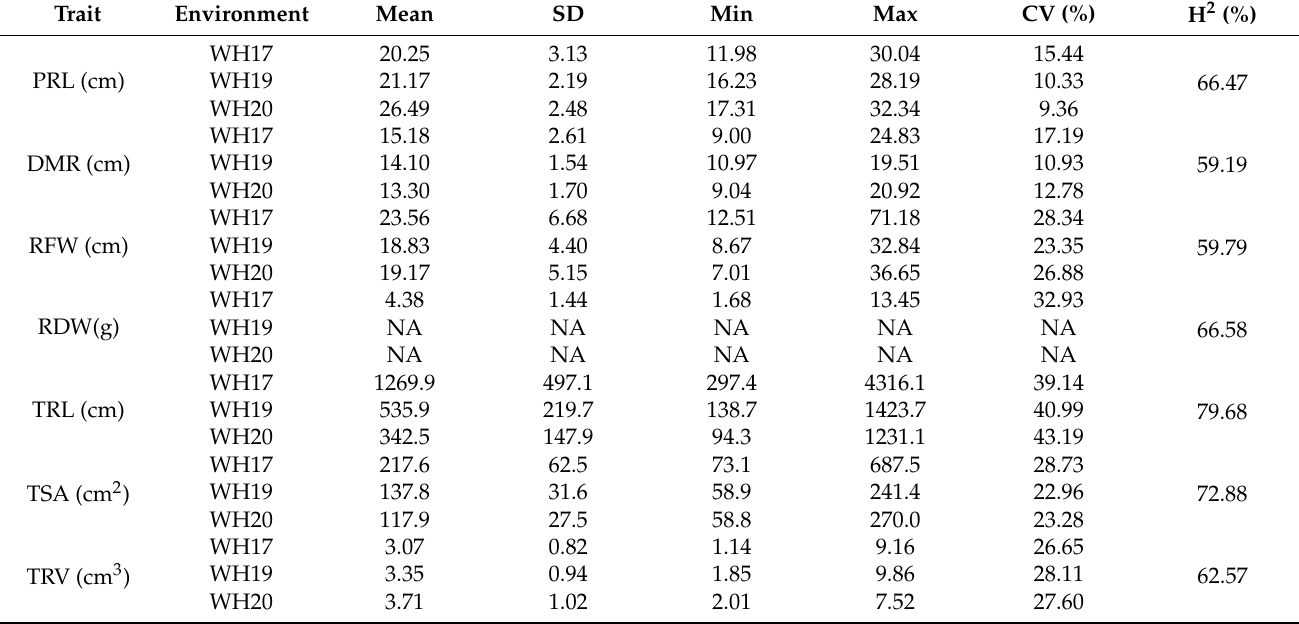
Table 2. Phenotypic variations for root-related traits of 338 B. napus